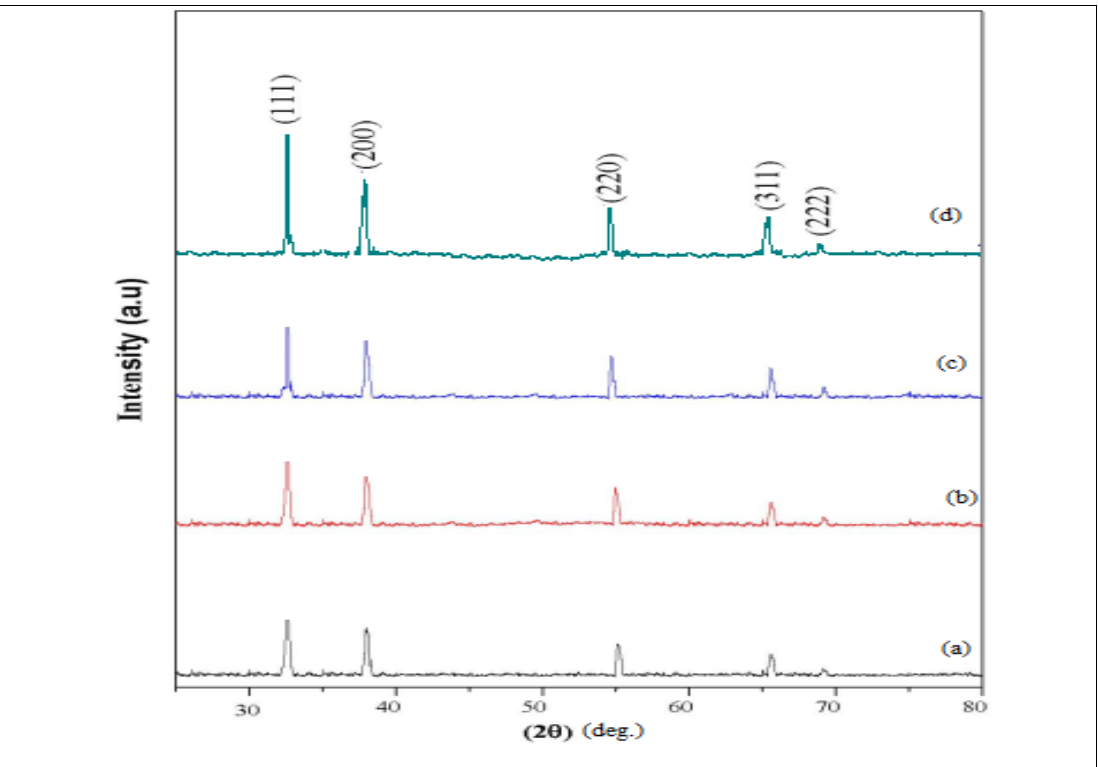
Fig. 1: XRD pattern of a) pure CdO films b) 2%Ce, c) 4%:Ce, and d) 6% Ce deposited on glass substrate.